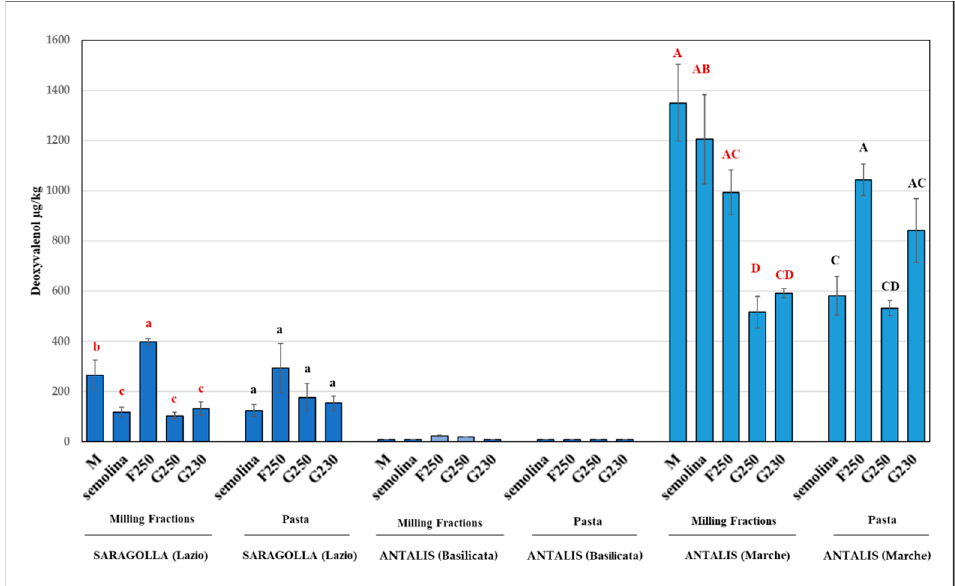
Figure 4. Group II: average content of DON in the micronised (M) and air-classified fractions (F and G) of the durum wheat samples that tested positive; different letters within each group indicate significant difference ( p < 0.05). Different colored letters are referred to different sample types (red for milling fractions and black for pasta), n = 3.